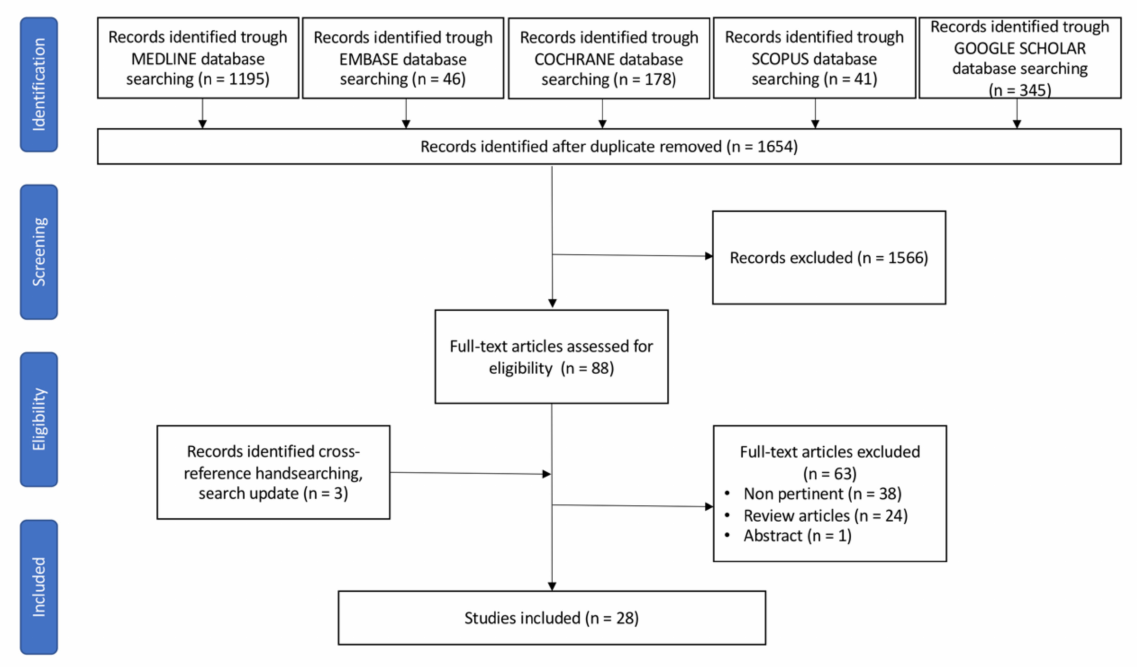
Figure 1. PRISMA flow diagram for study search, selection, inclusion, and exclusion. Example of the research